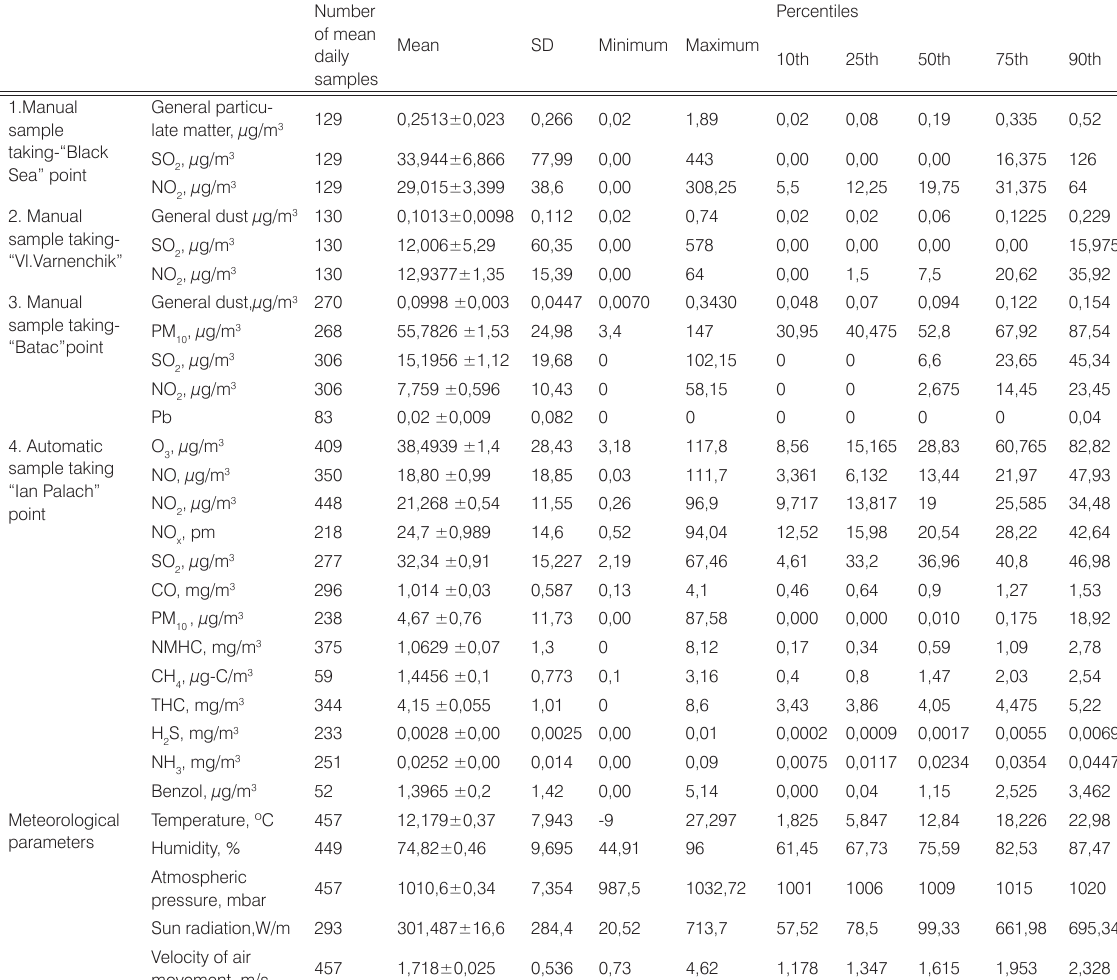
Table 2. Characteristics of the atmospheric pollutants and the meteorological parameters in the study period (October 2004 - December 2005).